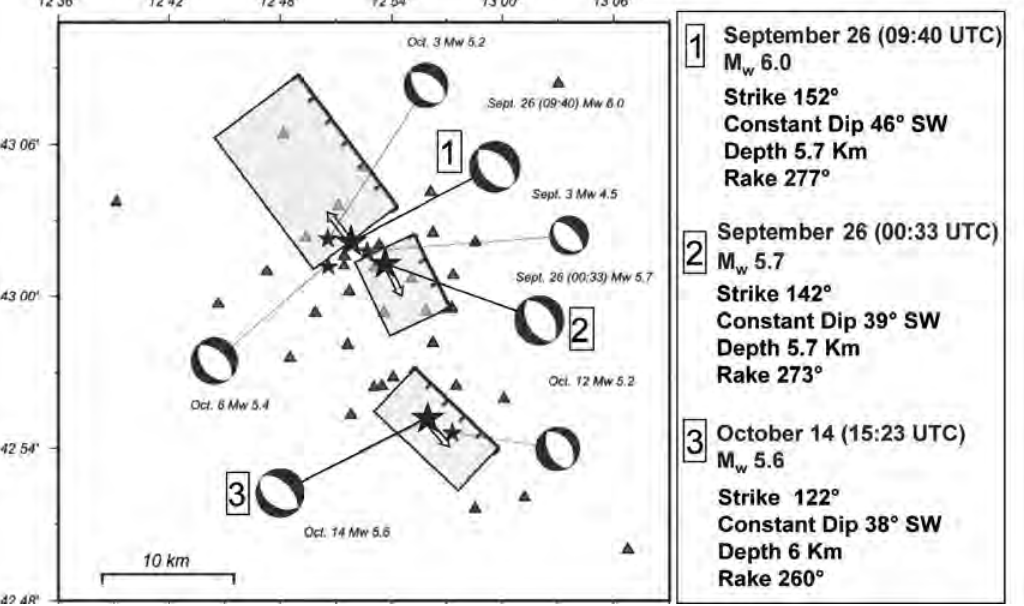
Fig. 2. Surface projections of the faults that ruptured during the three largest events (numbered, north to south) (modified by Chiaraluce et al. , 2004). The fault-plane solutions of the 3 September foreshock and of the six shocks with M>5 are shown. The distribution of the temporary seismic stations (grey triangles) is also mapped. To the right: the fault parameters for the three mainshocks according to Chiaraluce et al. (2003). The authors de- fine shallow, gently dipping blind normal faults; the fault planes are not listric, but rather maintain a constant dip through the entire seismogenic